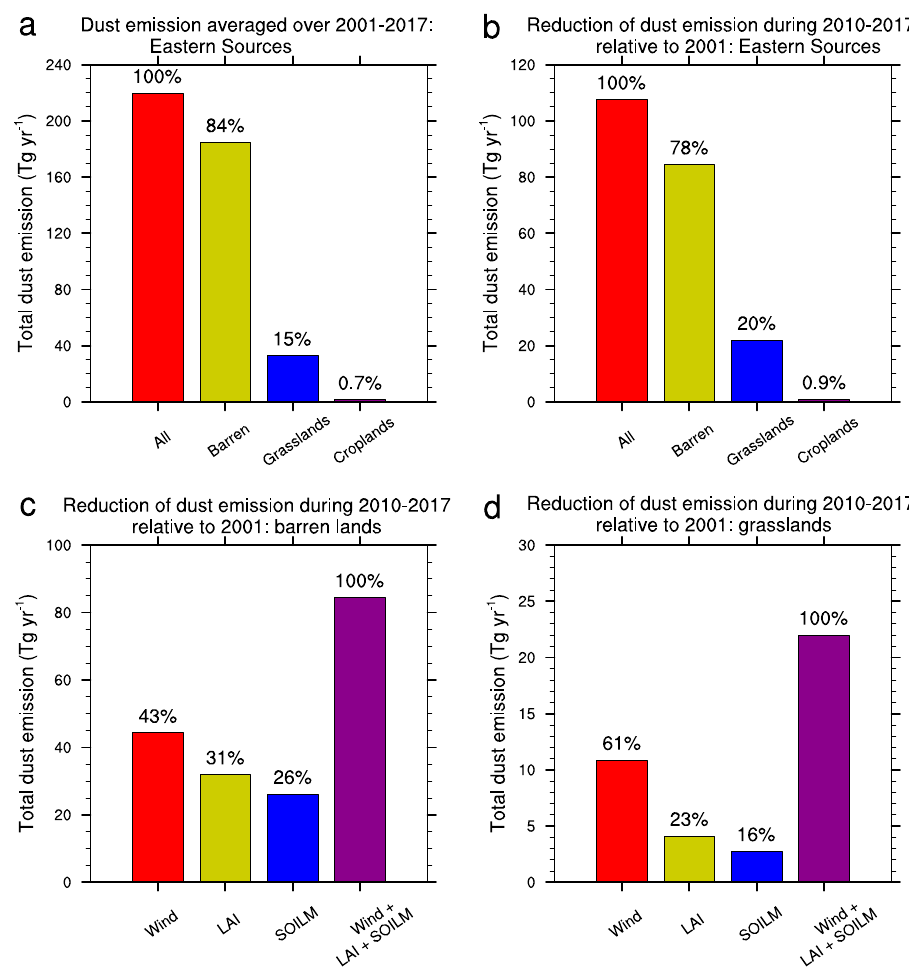
Fig.4|Dustemissionanditschangeoverdifferentlandcovertypes.a Regional accumulated dust emission (Tg yr − 1 ) averaged over 2001 – 2017 over the whole Eastern Sources and contributions from the barren lands, grasslands, and croplands, respectively. b Reduction of dust emission (Tg yr − 1 ) during 2010 − 2017 relative to 2001 over the whole Eastern Sources and contributions from the barren lands, grasslands, and croplands, respectively. The results